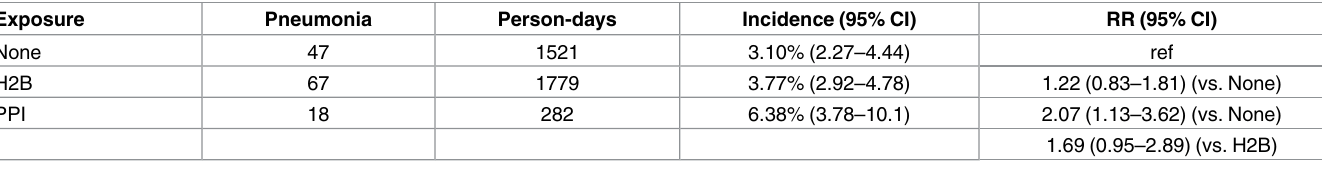
Table 2. Incidence and Relative